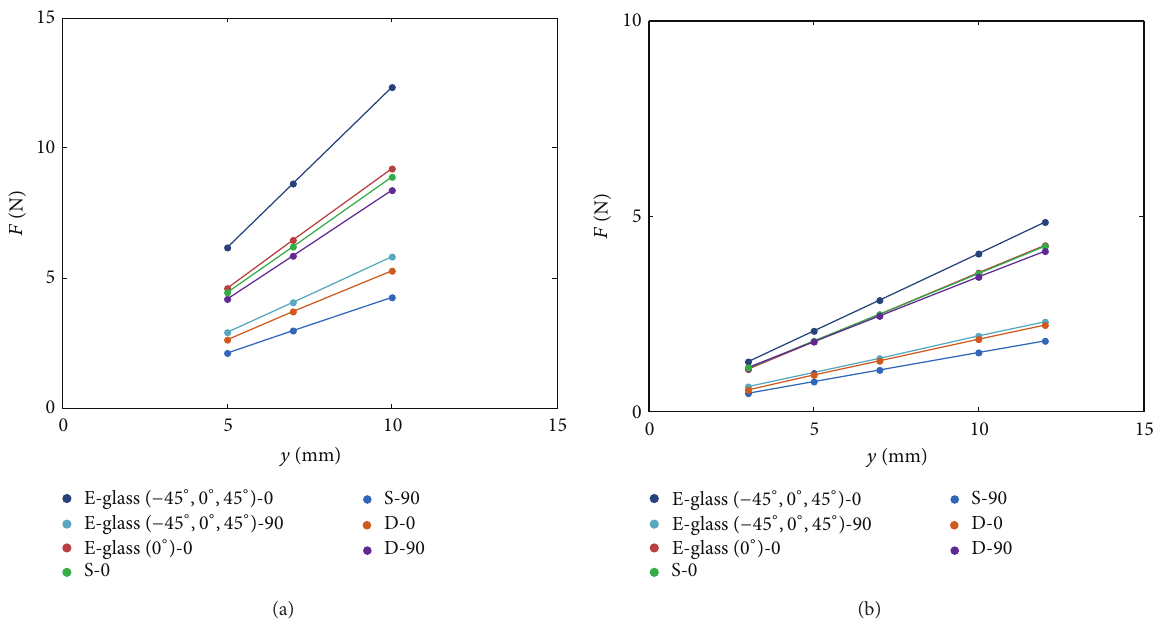
Figure 12: The force-displacement relation of the fiberglass composite strips (a) and semicircular composites (b) made by the E-glass (− 45 ∘ , 0 ∘ , 45 ∘ ) and the E-glass ( 0 ∘ ) in seven different material and layer configurations.